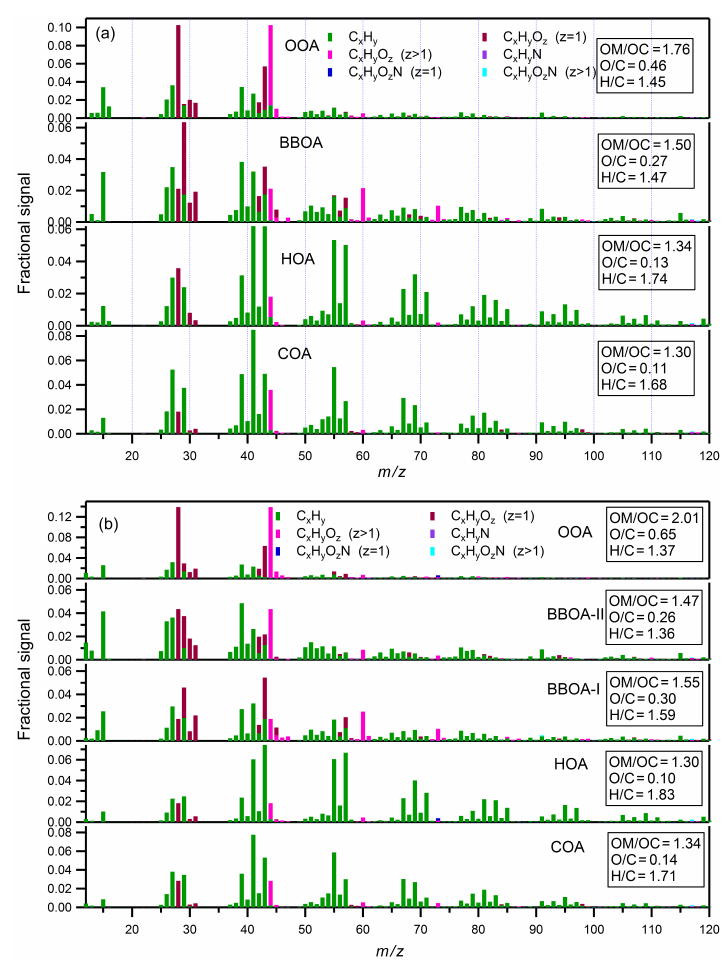
Figure 8. High-resolution AMS mass spectra for the factors in (a) Athens and (b) Patras.